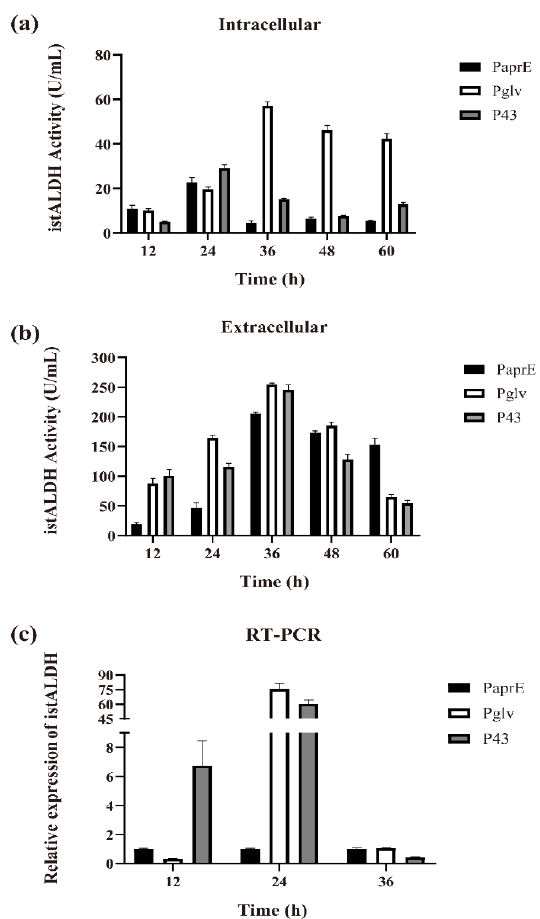
Figure 2. The intracellular ( a ) and extracellular ( b ) istALDH activities, and the relative expression of istALDH ( c ) of recombinant B. subtilis strains with different promoters. The experimental data were expressed as means ± standard deviations (SDs) of at least three independent experiments.